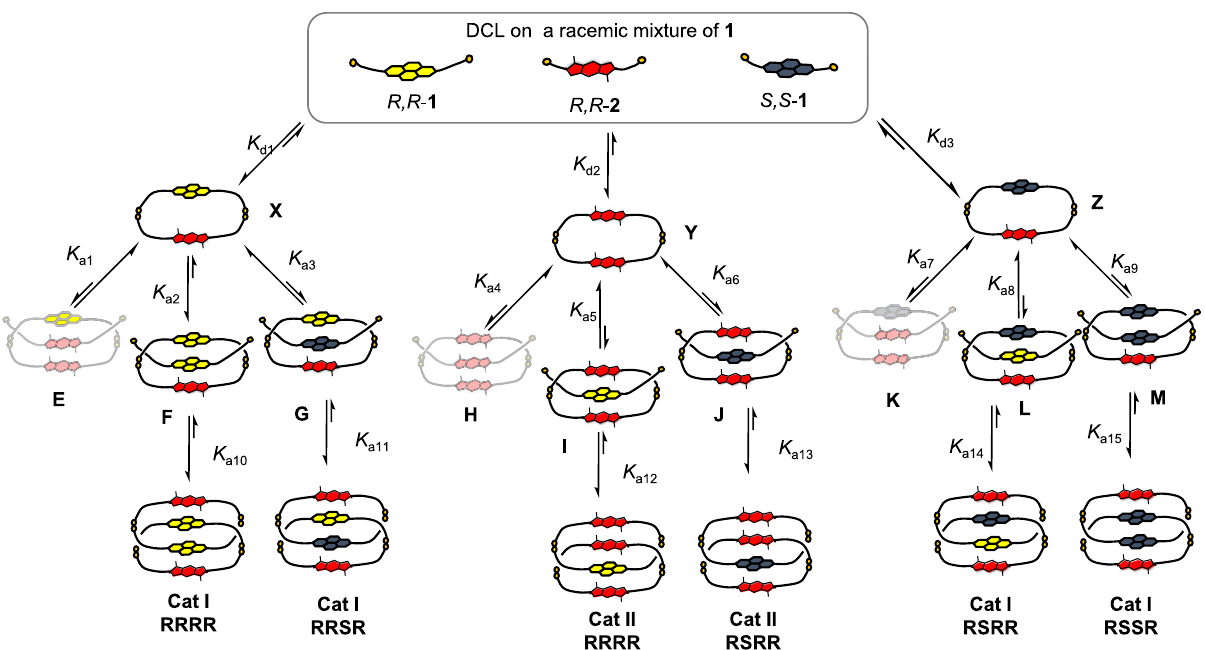
Fig. 4 Rationalising the DCLs outcome. Schematic representation (simpli fi ed) of the pathways leading to Cat I RRRR and Cat II RSRR . The equilibrium arrows show the relative position of the equilibrium based on theoretical and experimental data. The faded structures are either present in less than 1% or not present in the DCLs analysed. K d = dimerisation constant, K a = association